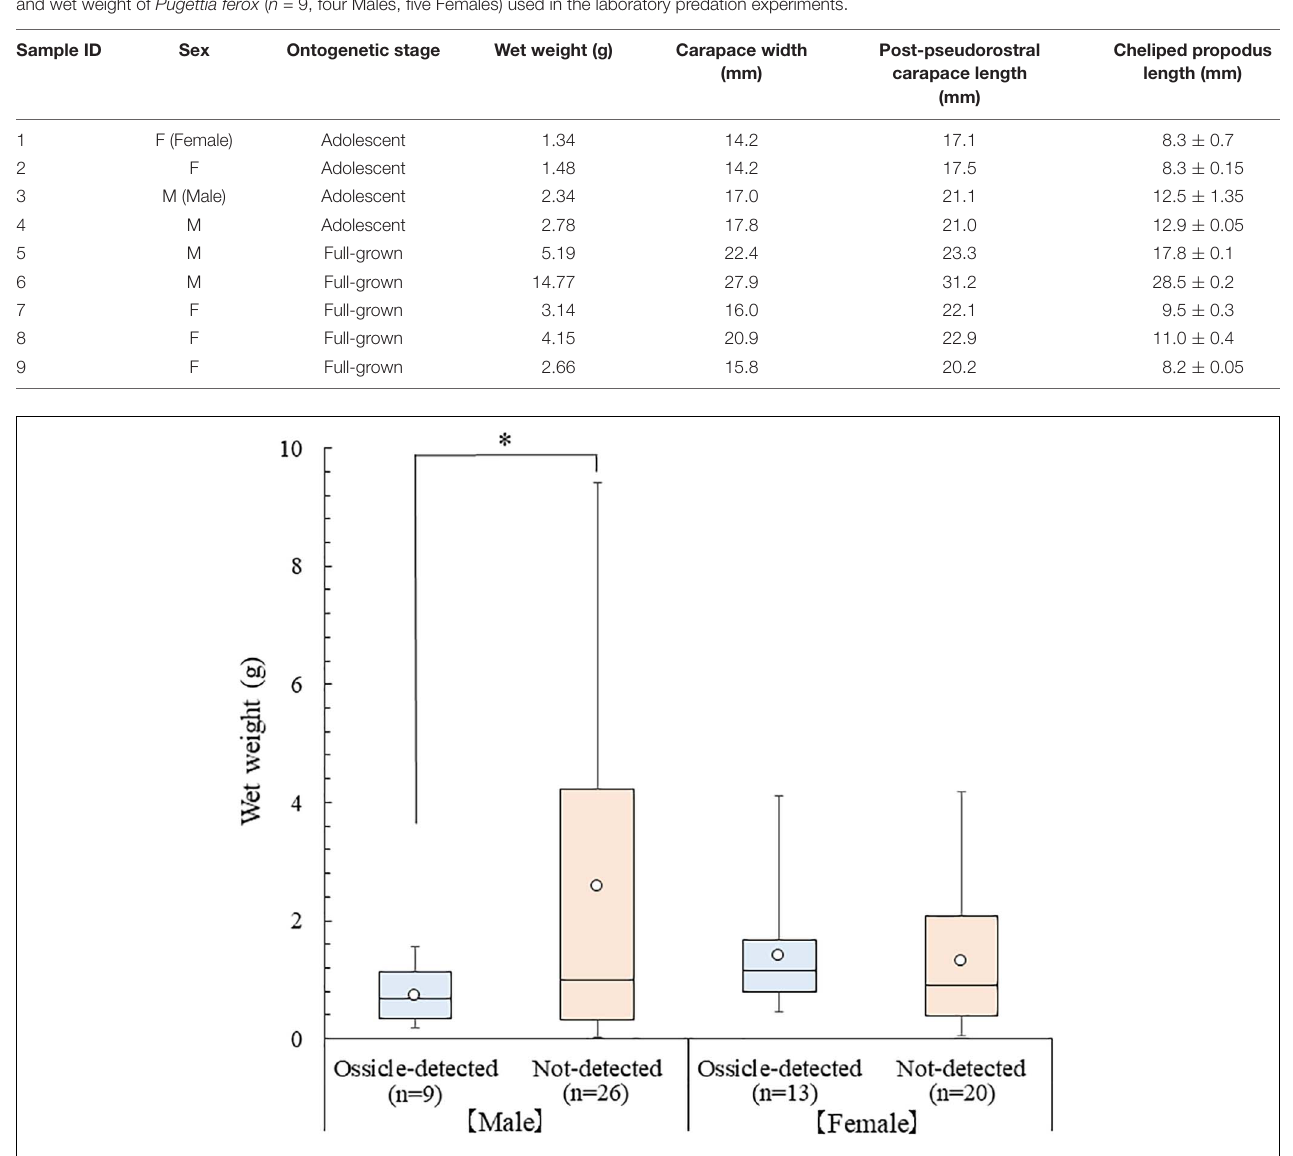
FIGURE 3 | Box plot of wet weight between the ossicle-detected and not-detected groups in male and female P. ferox collected within artificial intermediate sea cucumber reefs for releasing hatchery-produced juveniles in December 2018. An open circle ( (cid:13) ) represents the average wet weight. The top and the bottom line of the box show the first and third quartiles, and the middle line is the median. The upper (lower) whisker displays the maximum (minimum) value. Asterisk ( ∗ ) indicates statistical significance ( p <